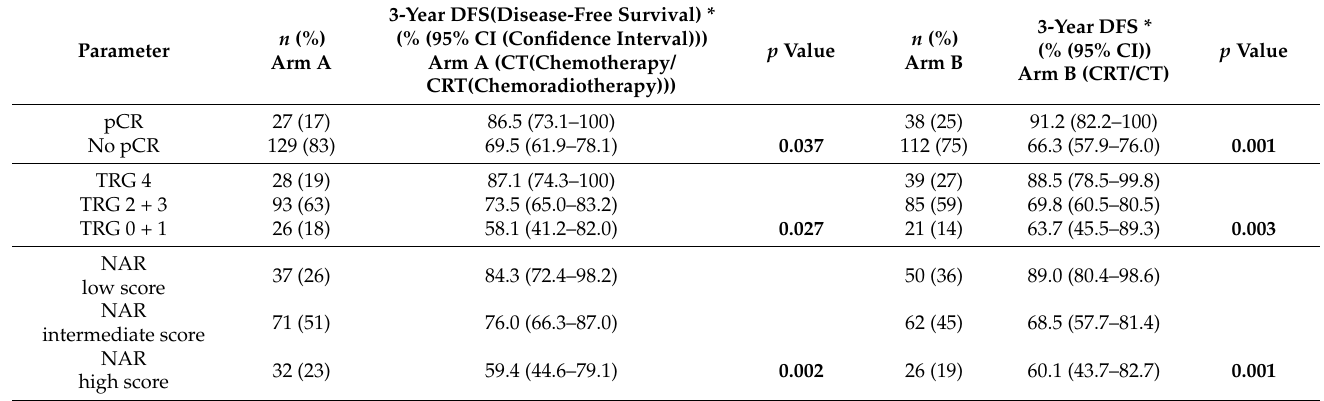
Table 2. Distribution of pCR, TRG and NAR score in the two treatment arms of the CAO/ARO/AIO- 12 trial.